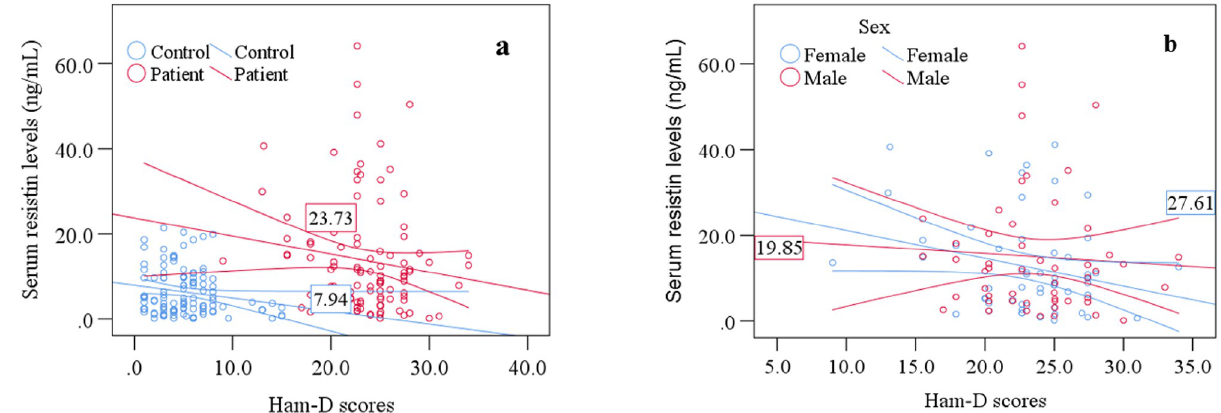
Fig 2. Scatter plot graphs showing association and mean difference of serum resistin levels with Ham-D scores of study participants. a: Patient and control specific association, b: Sex specific association among MDD patients.